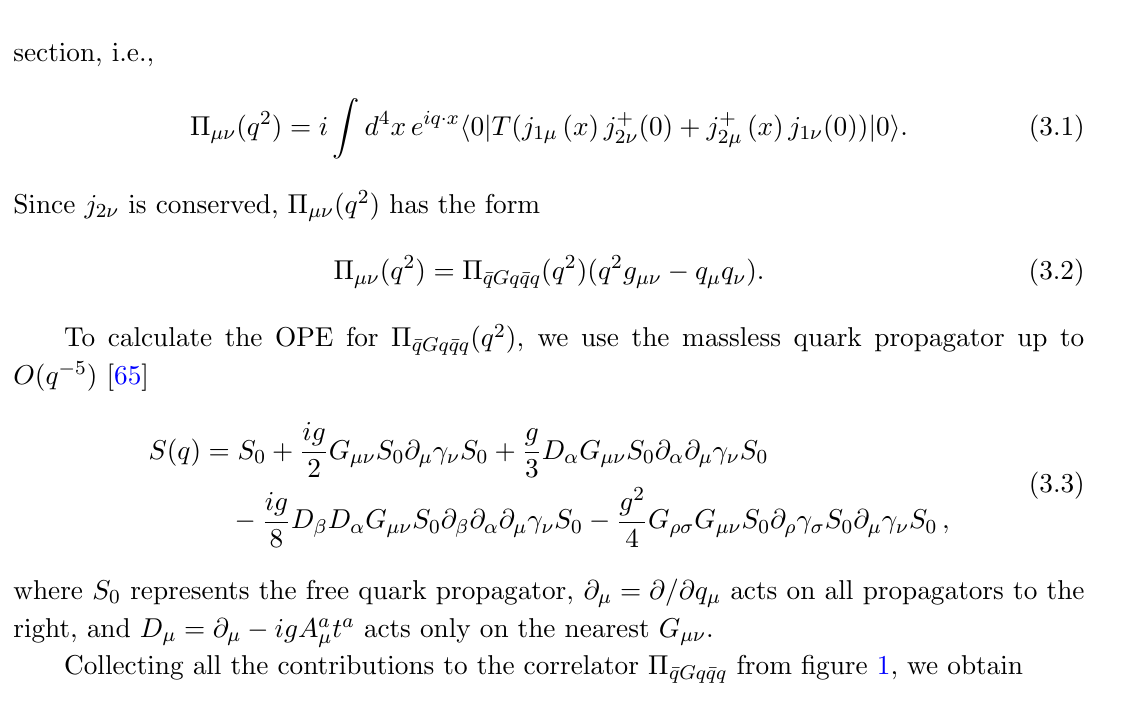
Figure 1 . Feynman diagrams for the (cid:22) qq -hybrid mixed